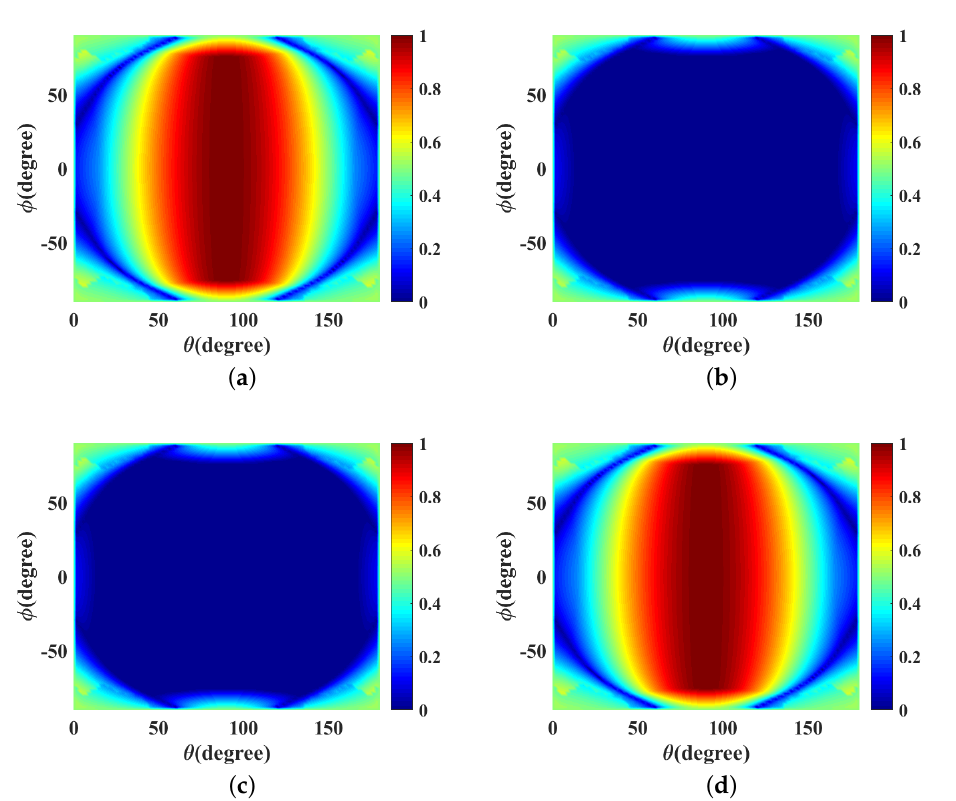
Figure 4. Copolar and cross-polar electric fields for LHEP and RHEP dipoles. ( a ) co-polarization pattern of LHEP dipoles; ( b ) cross-polarization pattern of RHEP dipoles; ( c ) cross-polarization pattern of LHEP dipoles; ( d ) co-polarization pattern of RHEP